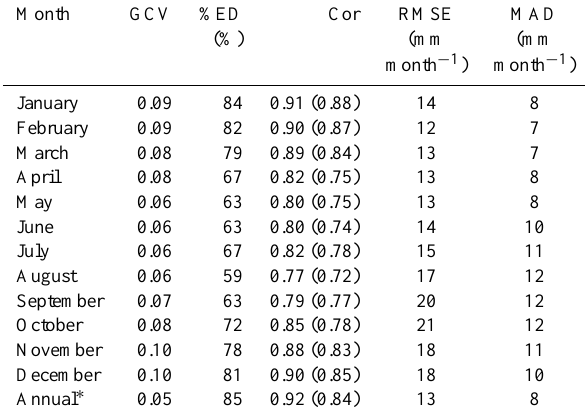
Table 1. Skills of the monthly total log-precipitation GAMs for the Northern European area, and of the annual total log-precipitation ( ∗ ) GAM for the Western Eurasian area. Values in parentheses represent total precipitation. The GCV score is defined in Eq. (2). The per- centage of explained deviance (%ED), the spatial correlation (Cor), the root-mean-square error (RMSE), and mean absolute difference (MAD) are defined in Eqs. (6–10),